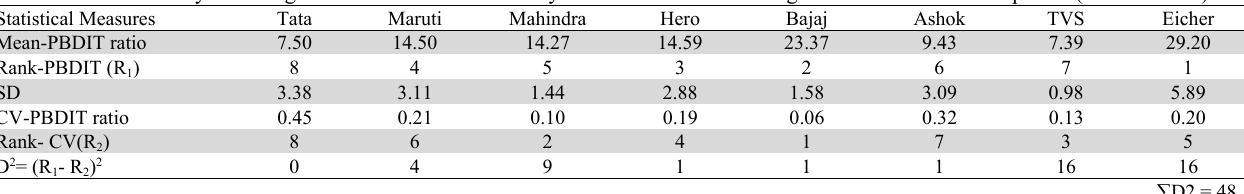
Source: Calculation based on ratios given in appendix 1.